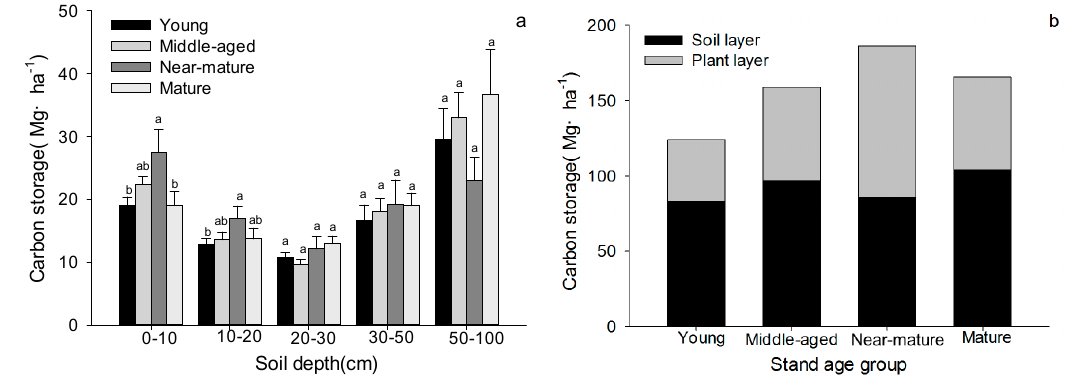
Figure 6. Carbon storage in soil and plant layer of Quercus variabilis stands (Means ± SE, n = 8, 6, 3 and 3 for young, middle-aged, near-mature and mature stands, respectively). ( a ) Soil carbon storage at different depth; ( b ) forest ecosystem carbon storage among different age classes. Different small letters indicated significant difference in the same indicators among different forest age classes.